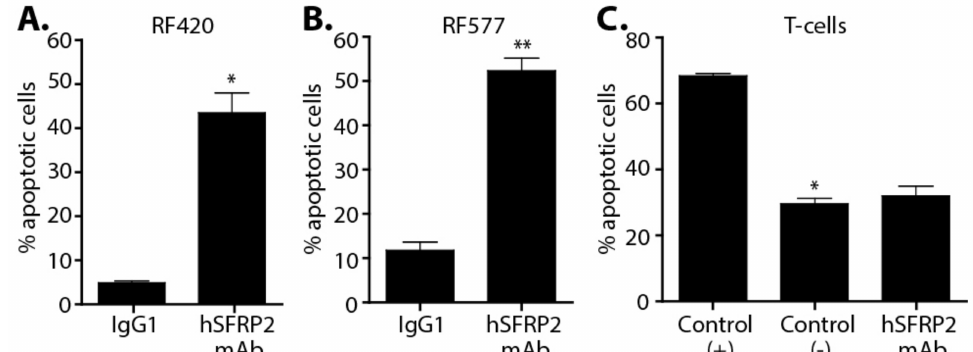
Figure 9. Impact of hSFPR2 mAb treatment on osteosarcoma and T-cell apoptosis. ( A , B ) Apoptosis of RF420 ( A ) and RF577 ( B ) OS tumor cells was measured after treatment for 1 h with 10 µ M IgG1 control or hSFPR2 mAb using an apoptosis detection kit allowing the identification of FITC + apoptotic cells. The percentage of apoptotic cells after treatment with hSFRP2 mAb increased significantly. ( A) In RF420 cells, apoptosis increased from 4.9 0.19% in IgG1 treated cells to 43.54 0.16% in cells treated with hSFRP2 mAb ( n = 12, * p < 0.001) and, ( B) in RF577 cells, hSFRP2 mAb increased apoptosis to 52.4 0.08% from 11.8 0.3% in IgG-treated cells ( n = 12, ** p < 0.0001). ( C ) Apoptosis in CD4 + and CD8 + T-cells. T-cells were isolated from C57BL/6 mouse spleens, treated with IgG1 (10 µ M) or hSFRP2 mAb (10 µ M) for 24 h, stained with Hoechst and Annexin V and then analyzed by flow cytometry. A positive control for apoptosis was obtained from T-cells passed through various freeze/thaw cycles in DMSO-containing medium was used for the experiment. The percentage of apoptotic cells in the IgG1-treated control samples was significantly lower than in the positive control group ( n = 3, * p < 0.001). Compared to the IgG1-treated samples, the percentage of apoptotic cells remained unchanged in the hSFRP2 mAb-treated samples ( n = 3, p =